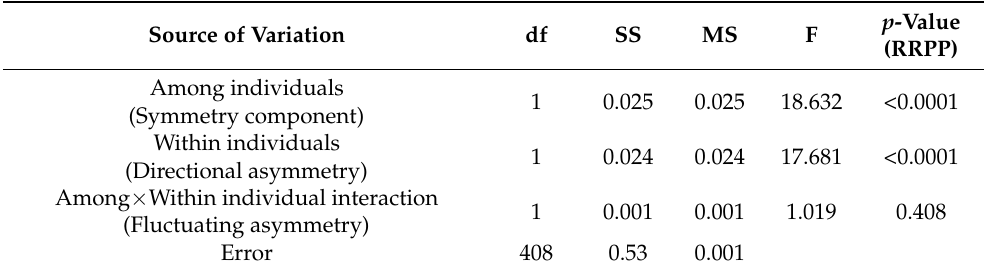
Table 1. Output of two-way Procrustes ANOVA applied to the symmetric and asymmetric shape components. Sex was nested in the variations of both components. df: degrees of freedom, SS: sum of squares, MS: Mean squares, F: F-ratio, p -value: probability of significance estimated by Randomized Residuals in a Permutation Procedure